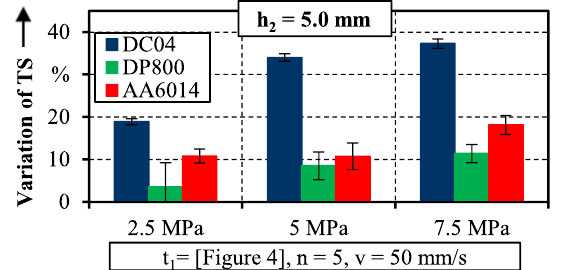
Fig. 11. Modi fi cation of the tensile strength TS in tensile tests after preloading in a drawbead passage h 2 =5.0